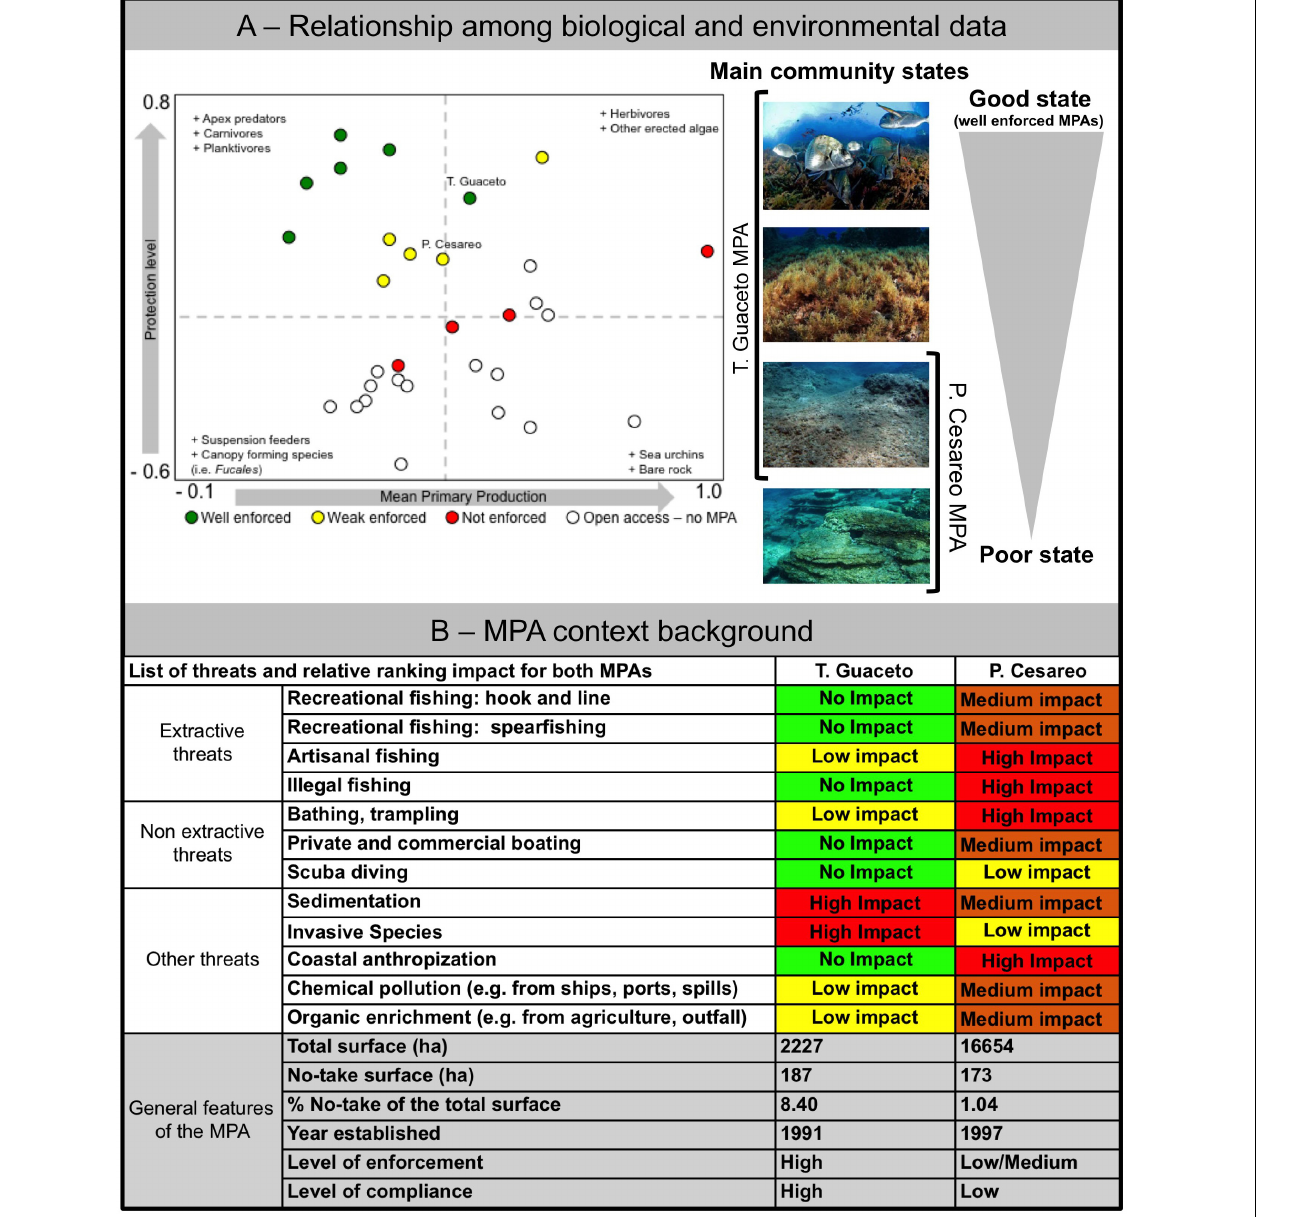
FIGURE 4 | (A) Synthesis of the relationships between the structure of Mediterranean rocky reef ecosystems across a gradient of protection, with a focus on the Torre Guaceto and Porto Cesareo MPAs. (B) Information about the context for the two MPAs is reported. Data were extracted from Sala et al. (2012) and Giakoumi et al.